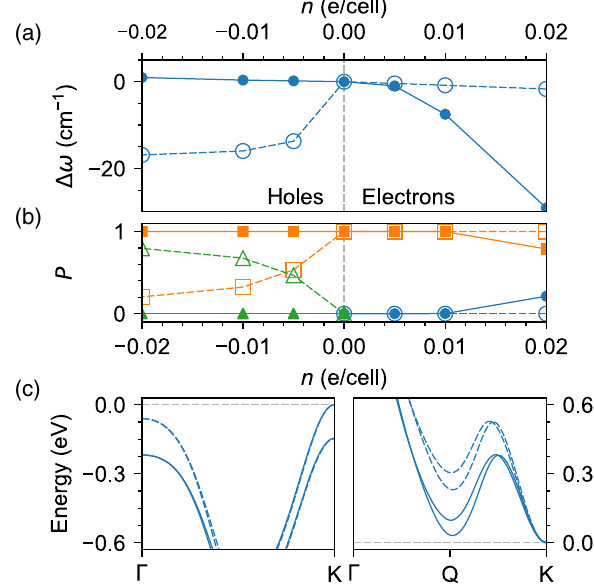
FIG. 7. Effect of the crystal structure of monolayer MoS 2 on the softening of the A 1 mode (a) and on the fractional occupation P g of the K (squares), Q (circles), and Γ (triangles) valleys (b) upon carrier accumulation. Empty symbols represent quantities ob- tained by means of ab initio calculations performed using the fully relaxed DFT structure of monolayer MoS 2 , whereas full symbols represent the same quantities obtained using the ex- perimentally reported structure. Panel (c): Band structure of undoped MoS 2 close to the top of the valence bands (left) or to the bottom of the conduction bands (right) calculated using the experimentally reported (continuous lines) or the DFT-relaxed (dashed lines) crystal structure. Note how the different structures very significantly change the distance in energy between the top of the K and Γ valleys in the valence band and between the bottom of the K and Q valleys in the conduction band. As discussed in the main text, this distance in energy determines whether or not multiple valleys are occupied upon electron or hole accumulation in the calculations, with a corresponding strong effect on the shift of the A 1 phonon g